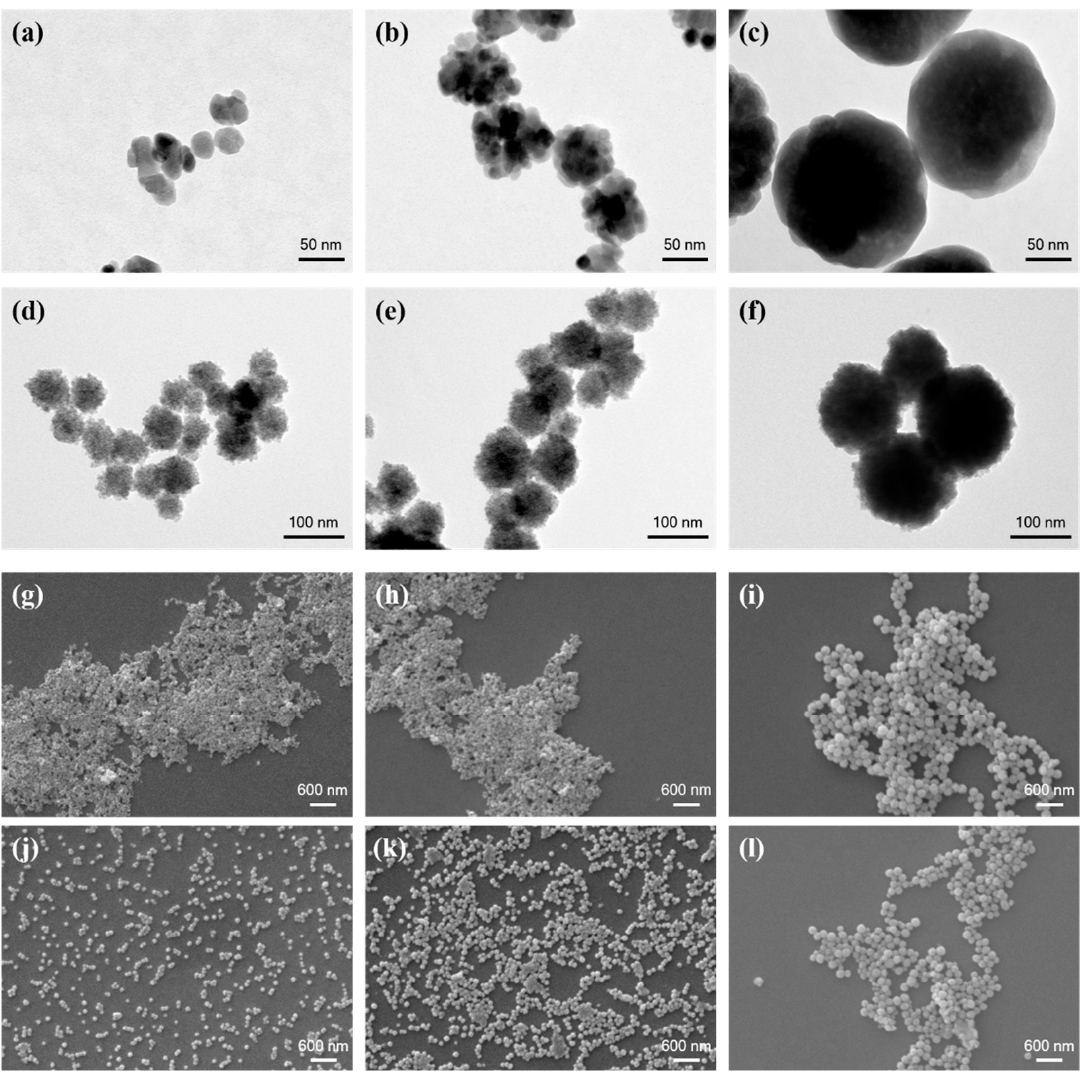
Figure 1. Characterization of CoFe 2 O 4 nanozyme and Fe 3 O 4 nanozyme by TEM and SEM. ( a – c ) TEM images of Fe 3 O 4 nanozymes with di ff erent sizes. ( d – f ) TEM images of CoFe 2 O 4 nanozymes with dif- ferent sizes. ( g – i ) SEM images of Fe 3 O 4 nanozymes with di ff erent sizes. ( j – l ) SEM images of CoFe 2 O 4 nanozymes with di ff erent sizes.